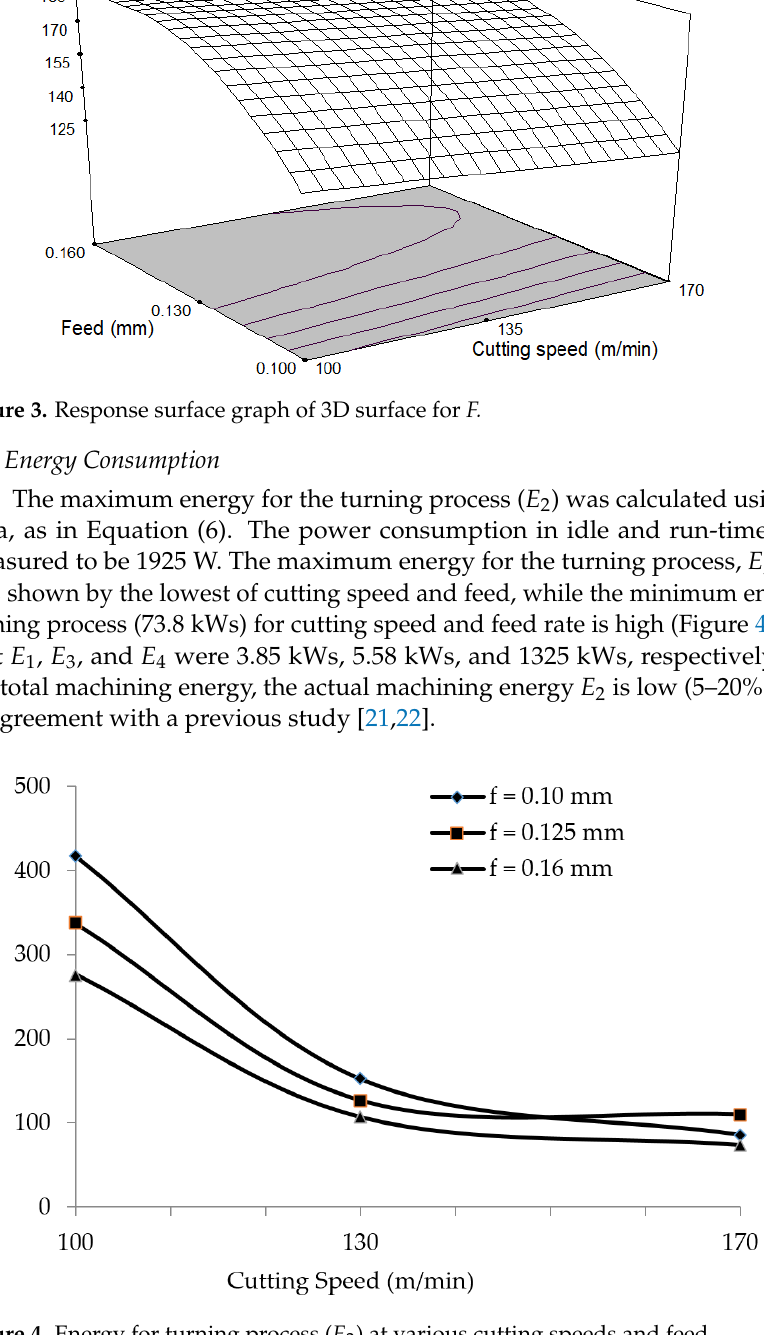
2 ) at various cutting speeds and